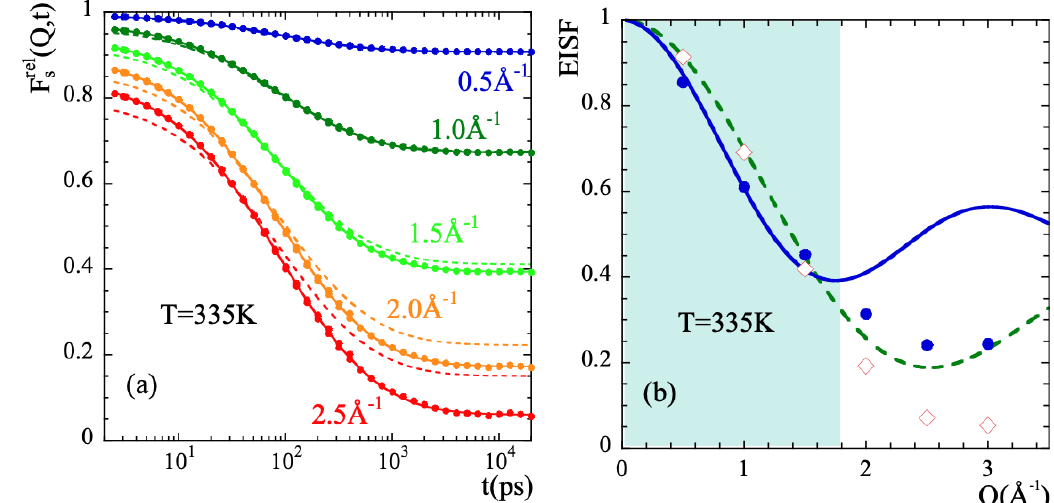
Figure 8. ( a ) Intermediate scattering function of methyl-group hydrogens corresponding to their motion relative to the methyl-group carbon F rel s ( Q , t ) at the Q -values indicated. The dotted lines are fits with the RRDM imposing the theoretical 3-fold EISF (dotted line in ( b )) and Q -independent σ and τ MG o , while in the solid lines free A, EISF, σ and τ MG o have been allowed. The such resulting EISF values are shown in ( b ) (diamonds). There, the ‘apparent EISF’ obtained from the deconvolution approach (see the text) is shown by the solid circles. The continuous line is a description of these data within the experimental window explored in Ref. [34] (shadowed area) in terms of Equation (18). The resulting d -value is 2.6 Å. In all cases the temperature is 335